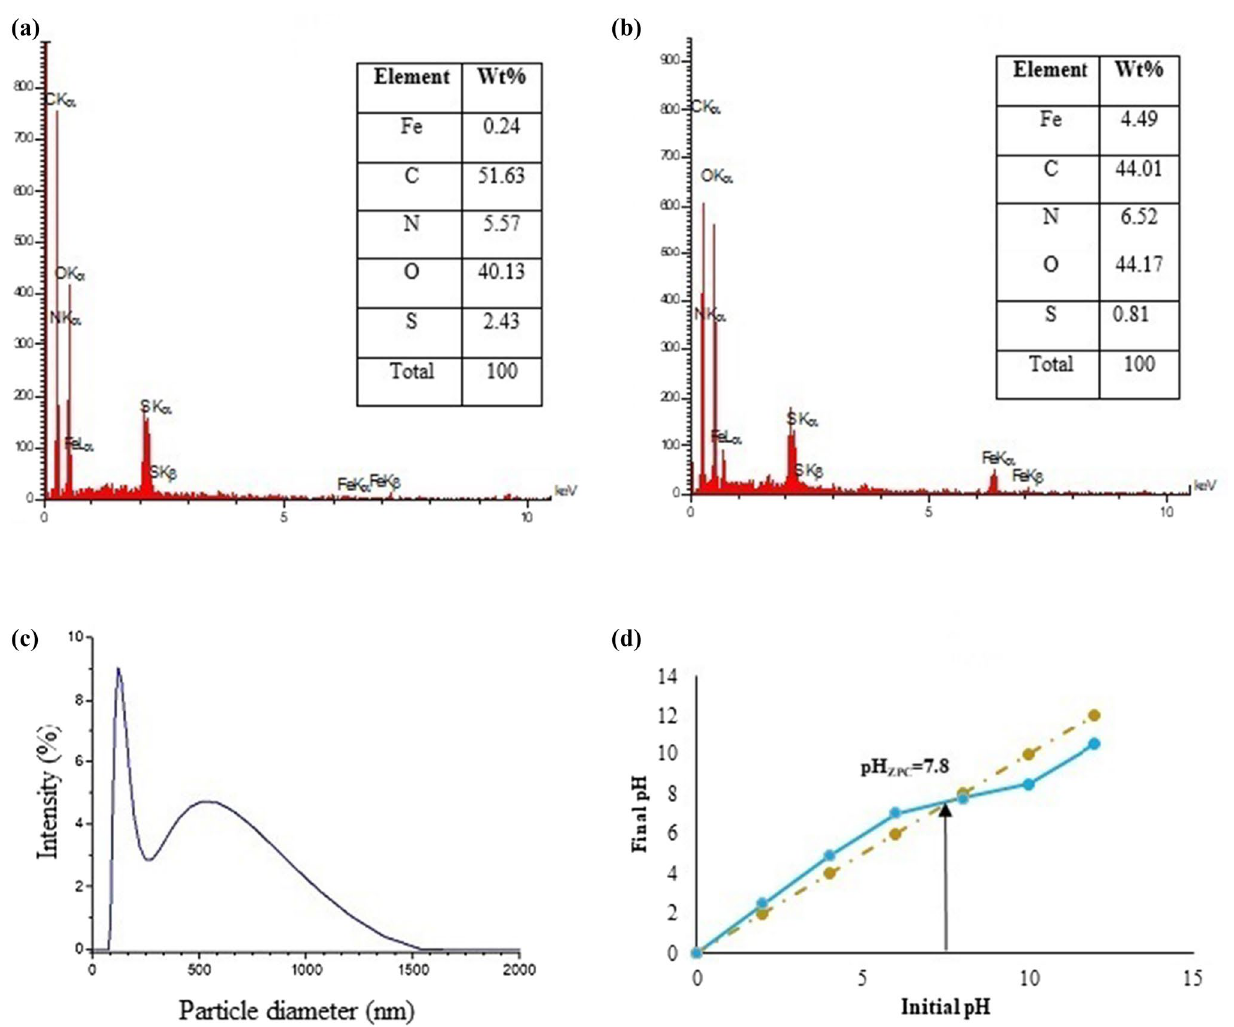
Fig. 4 EDX spectra and elemental composition of a SC, b Fe 3 O 4 /SC ncs, c DLS spectrum of synthesized Fe 3 O 4 /SC ncs, and d plot between final pH versus initial pH of